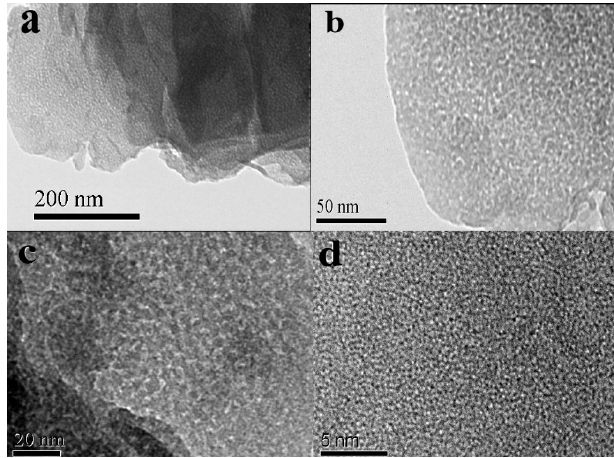
Figure 10. TEM ( a , b ) and HRTEM images ( c , d ) of porous silica prepared via acid leaching of kaolinite activated at 850 °C for 15 min.